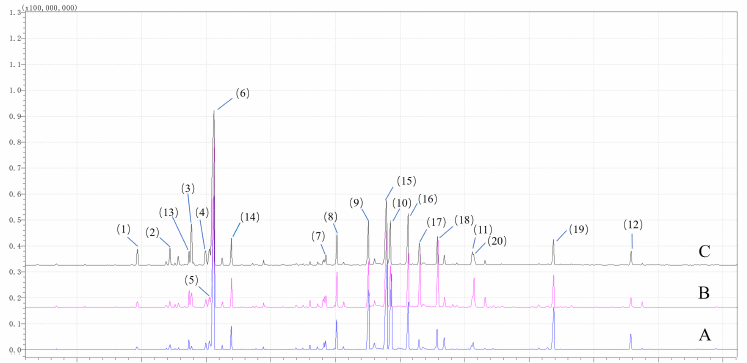
Figure 3. Total ion current chromatogram of A. tsao-ko essential oils (AEOs) from Wenshan ( A ), Nujiang ( B ), and Tengchong ( C ) by gas chromatography–mass spectrometry (GC-MS). Different colors represent different regions. Bule represents Wenshan (A), red represents Nujiang (B), and black represents Tengchong (C). The compounds with numbers correspond to the compounds listed in Table